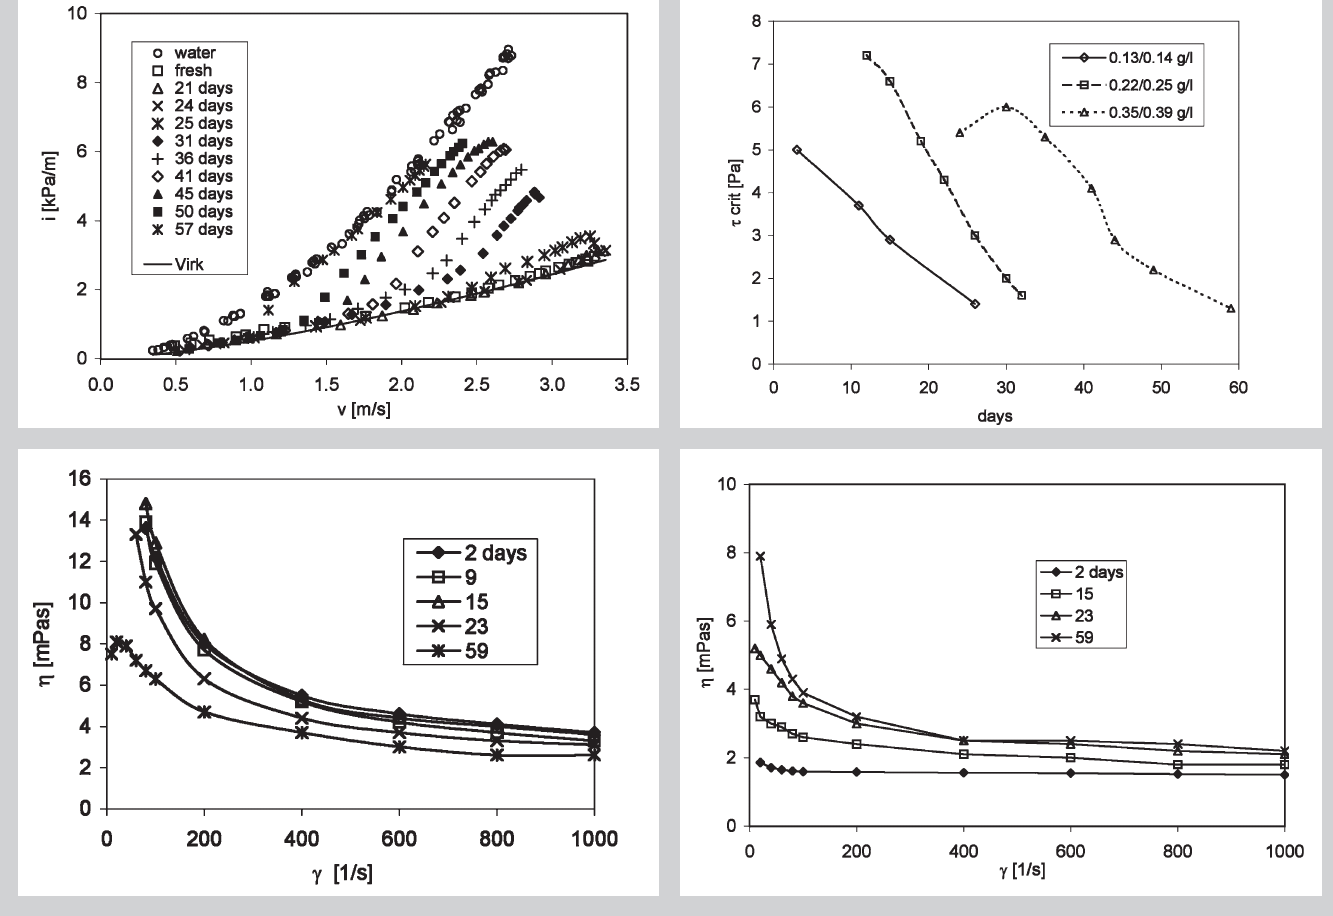
Figure 7 (left above): Degradation of the solution with shown concentration by age. Full curve is the Virk asymptote. Figure 8 (right above): Dependence of critical wall shear stress on age of the solution. Figure 9 (left below): Time change of apparent viscosity h , in a high concen- trated solution which showed relatively time inde- pendent drag reduction. Figure 10 (right below): Time change of apparent viscosity of the diluted solu-